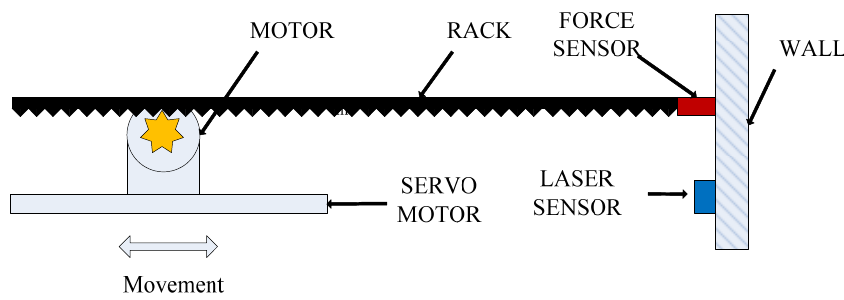
Figure 4. A sketch of the layout of the tests for the force model of the motor.